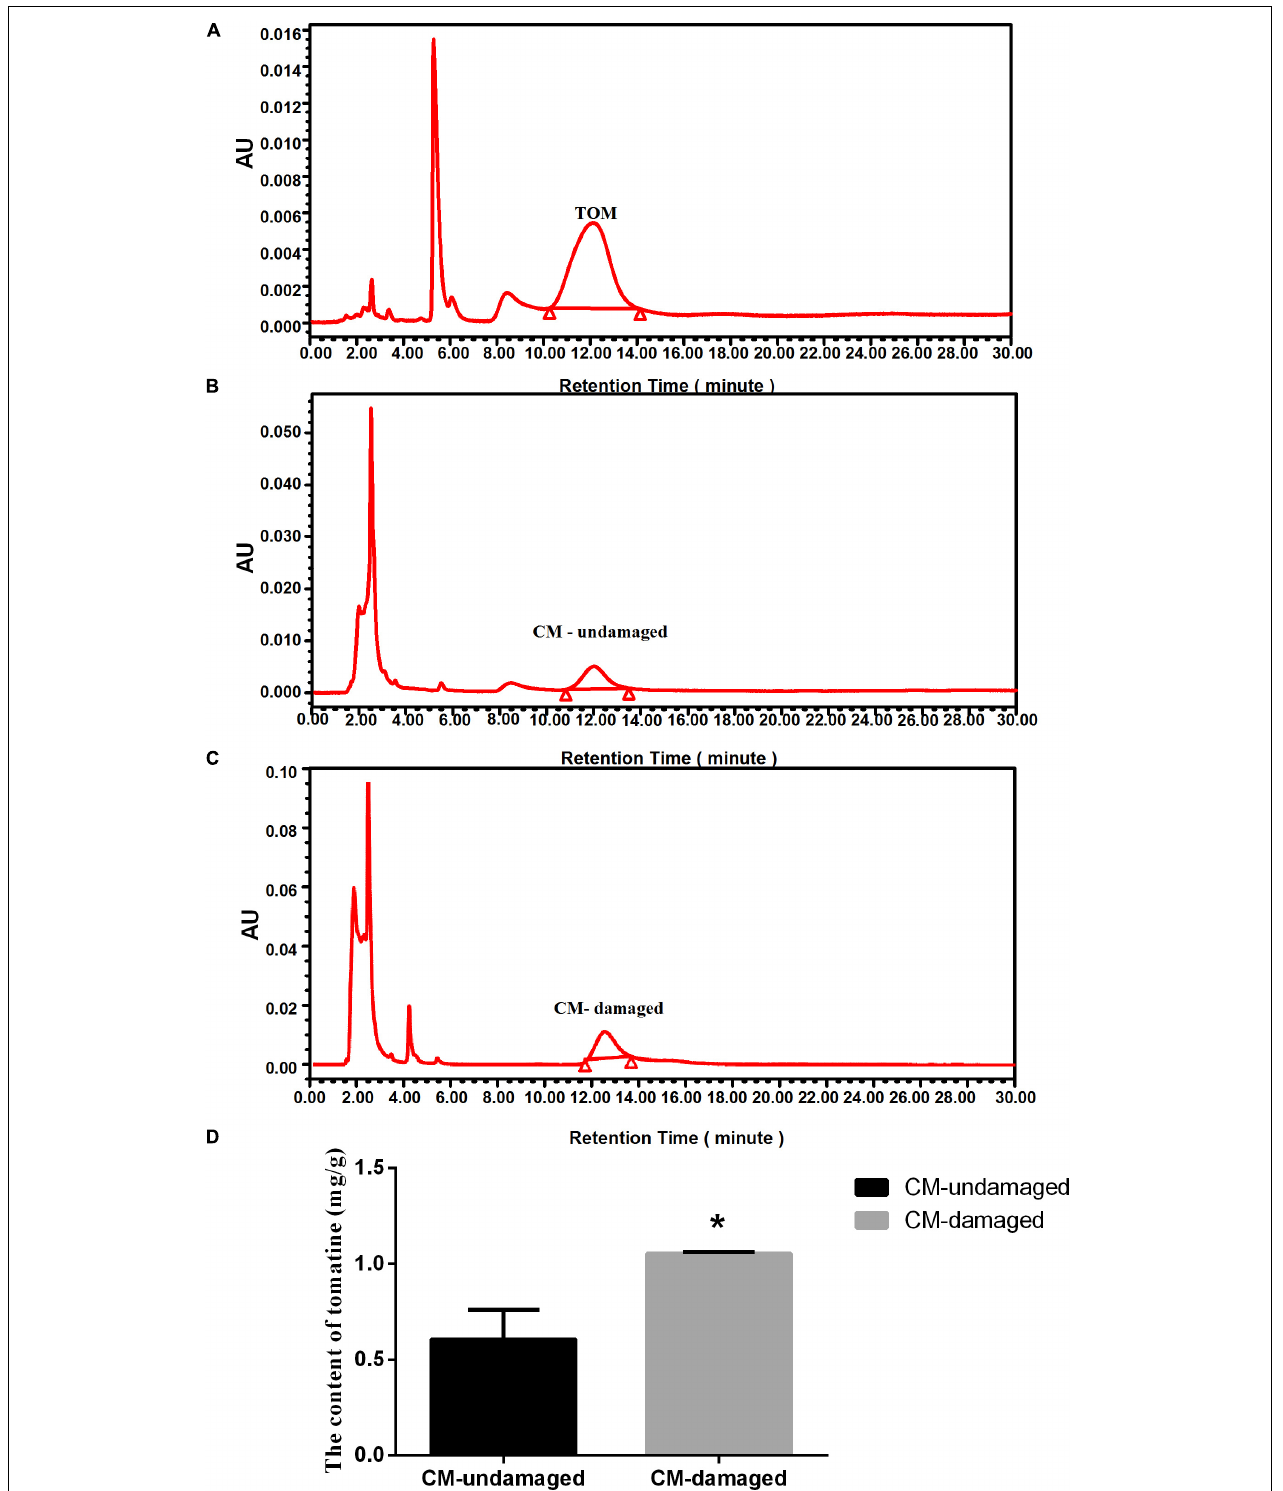
FIGURE 1 | Effect of S. litura -damage on tomatine content in CM tomatoes. (A) HPLC chromatographic profiles of the standard substance of TOM. (B) HPLC chromatographic profiles of TOM extracted from wild-type undamaged tomatoes. (C) HPLC chromatographic profiles of TOM extracted from S. litura -damaged CM tomatoes. (D) Contents of TOM in wild-type plants before and after S. litura damage. The tomatine concentration is expressed as mg/g solution for HPLC detection ( n = 5, ∗ p < 0.05, t -test).